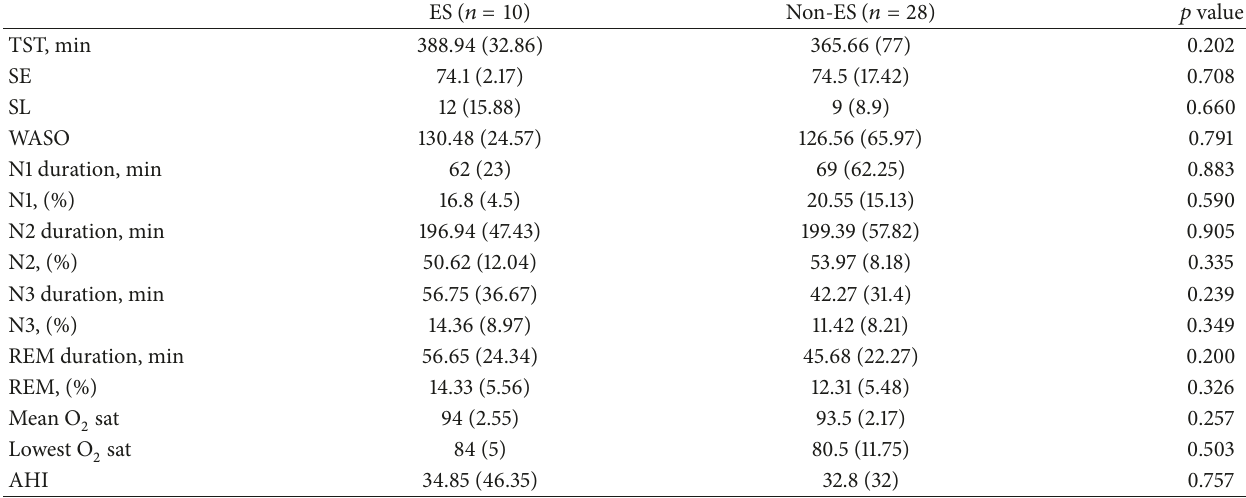
Table 2: Comparison of parameters of sleep macrostructure in OSA patients with and without ES (ES versus non-ES).